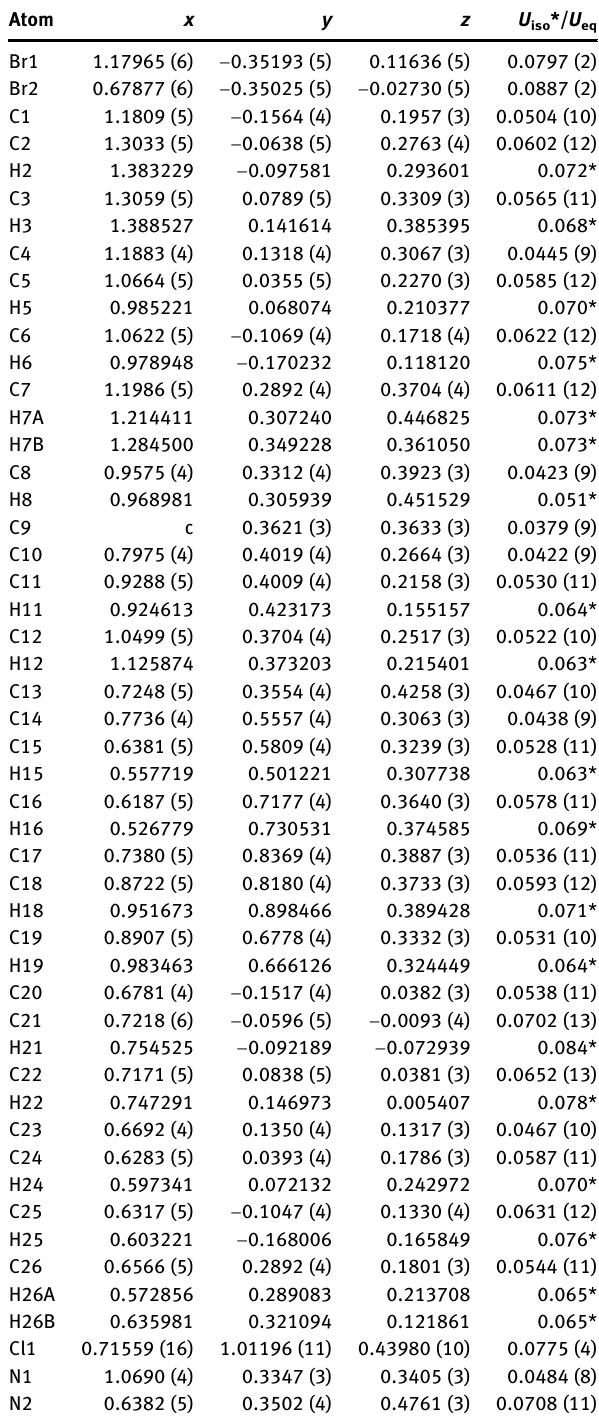
Table  : Fractional atomic coordinates and isotropic or equivalent isotropic displacement parameters (Å 